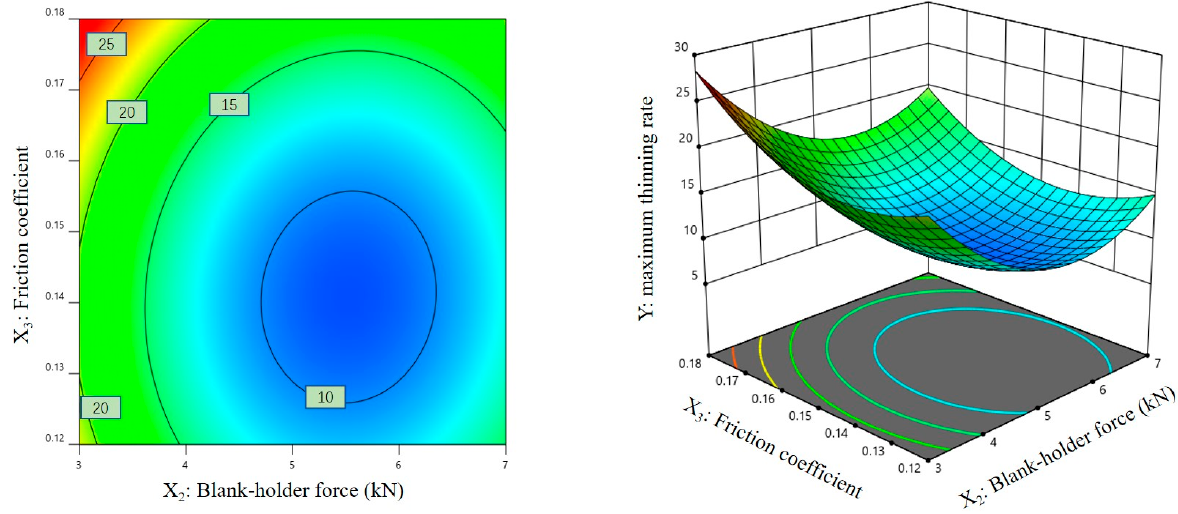
Figure 8. Contour plot and three-dimensional response surface graph of X 1 -X 3 on Y.